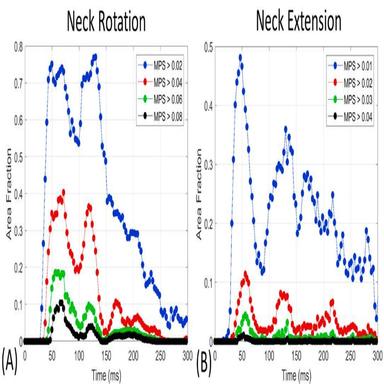
This figure shows the area fraction of maximum principal strain (MPS) as a function of time at various threshold values for ANGUS during (A) neck rotation and (B) neck extension. Time zero is the time at which the first image frame was acquired. Deformation increases sharply in response to rapid deceleration of the phantom and oscillates as a damped harmonic motion.